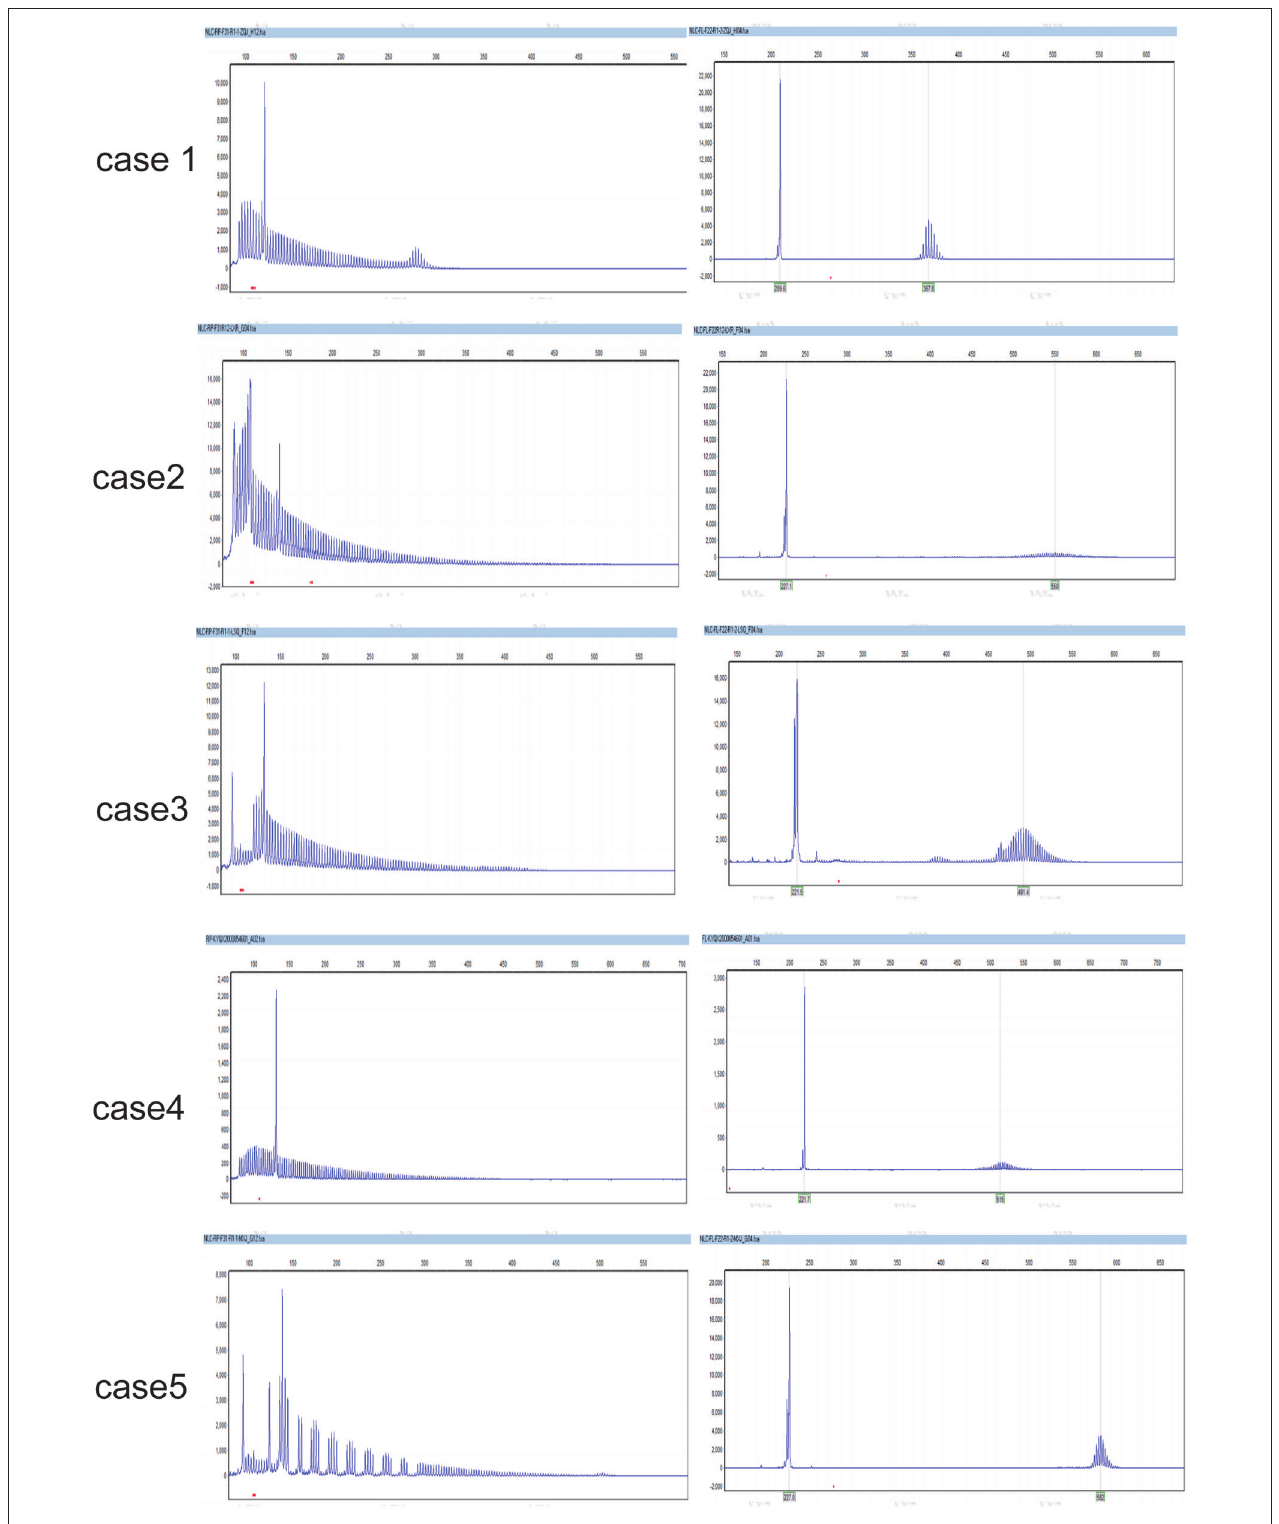
FIGURE 3 | The GGC repeats in the two alles of NOTCH2NLC in NIID cases. They were respectively, 66,12 (case 1); 128,20 (case 2); 105,15 (case 3); 103,20 (case 4); 142,18 (case 5).